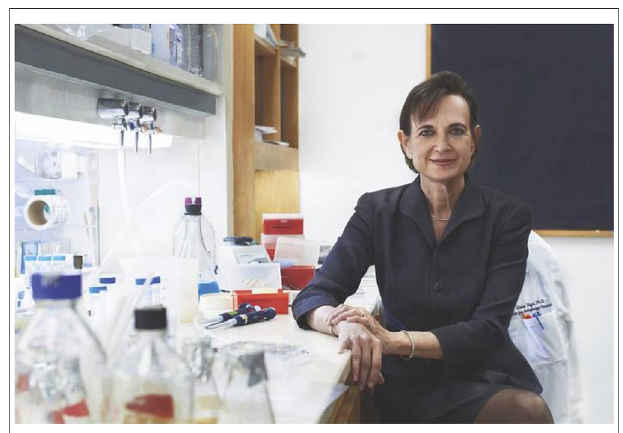
FIGURE 2 | Our very own Beth